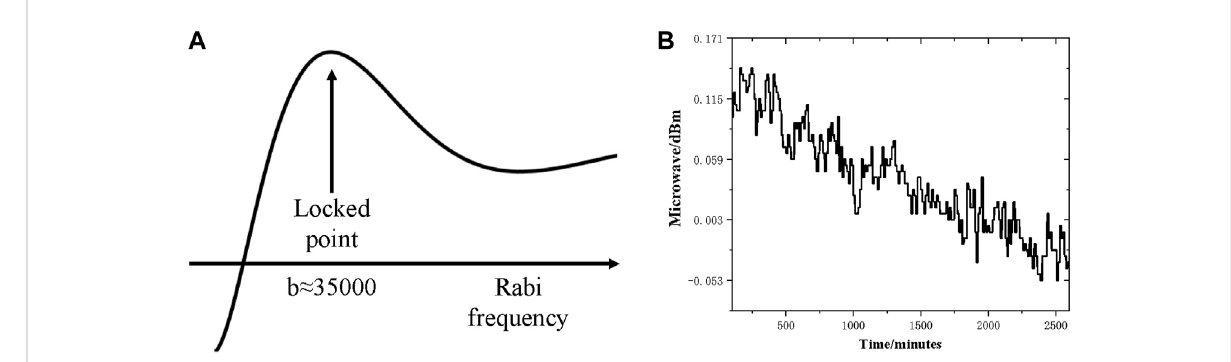
Microwave servo of the OPCB. (A) Transition probability curve. (B) Servo data.